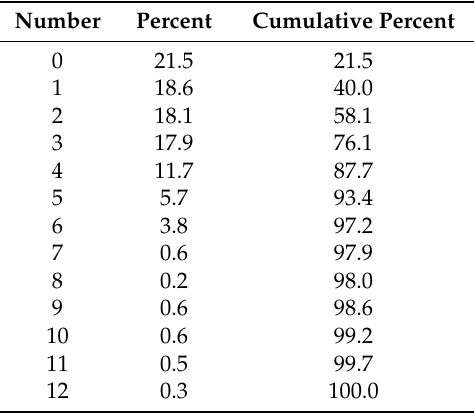
Table 3. Numbers of control